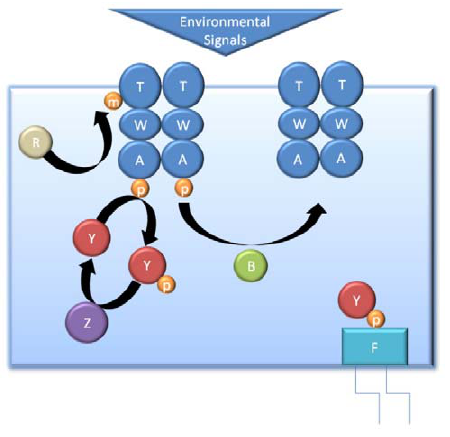
Figure 1. Schematic representation of the E.coli chemotaxis system. The Tar receptors are labelled T, CheW, CheY, CheA, CheZ, CheB and CheR are labelled as W, Y, A, B, Z and R respectively and the flagellal motor (FliM) is labelled as F. Phosphate and methyl groups are shown as orange cirles labelled p or m respectively.